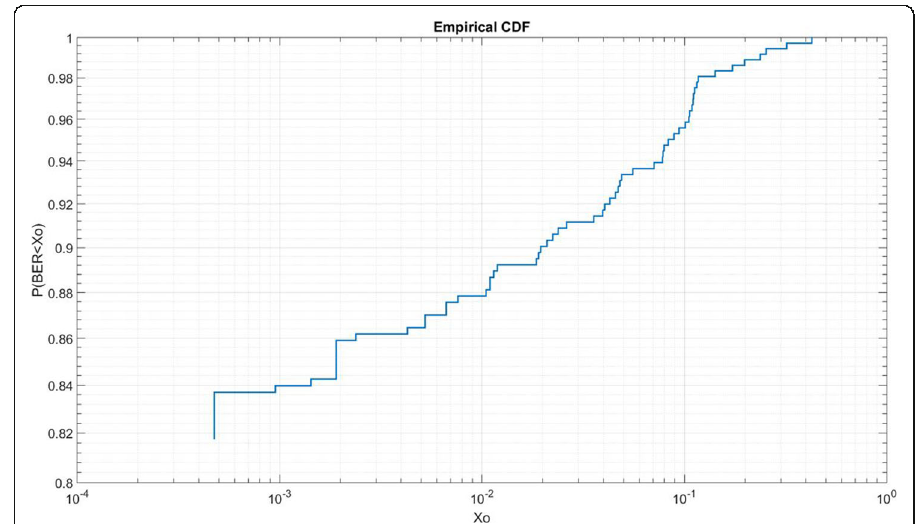
Fig. 17 CDF of remote test. Results of the implementation of a remote NVIS node data transmission test. This figure shows the probabilities of getting a BER (bit error rate) in a transmission (test made with more than 1 Mb)